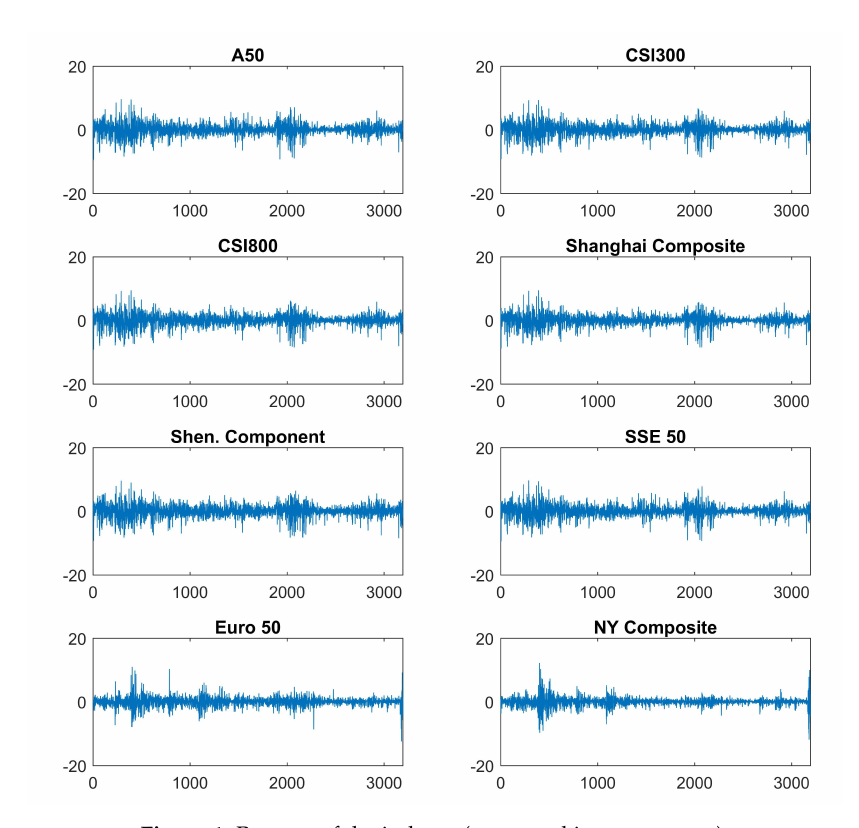
Figure 1. Returns of the indexes (measured in